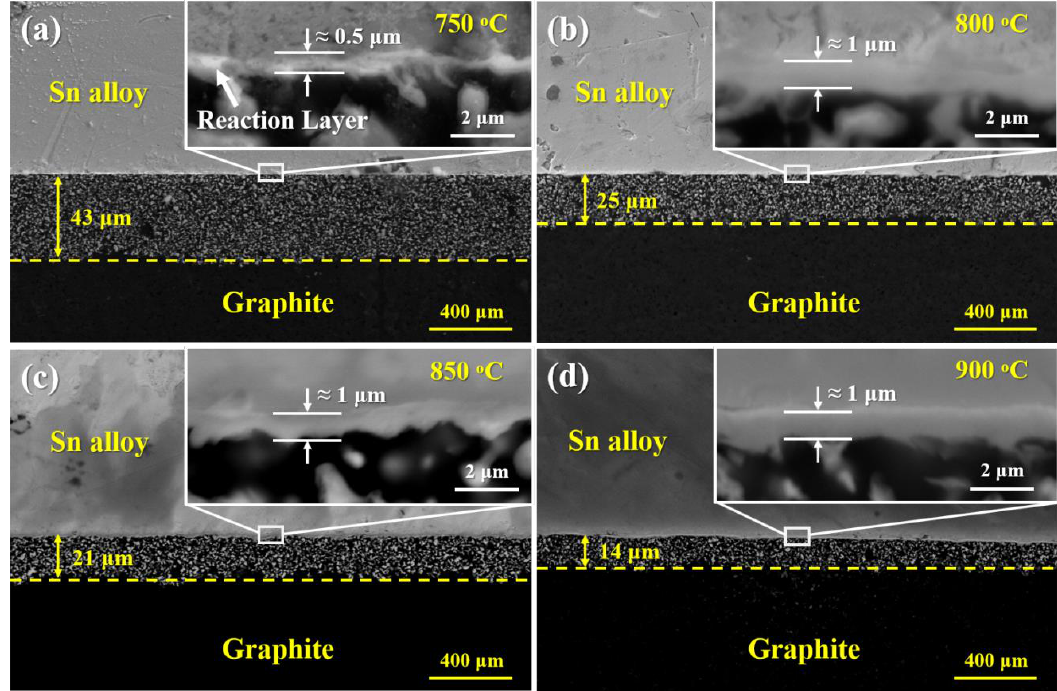
Figure 10. Sn-3V alloy/porous graphite interface microstructures obtained at the center of the solidified Sn-3V alloy droplet after isothermal wetting at ( a ) 750 °C, ( b ) 800 °C, ( c ) 850 °C and ( d ) 900 °C for 3 h.